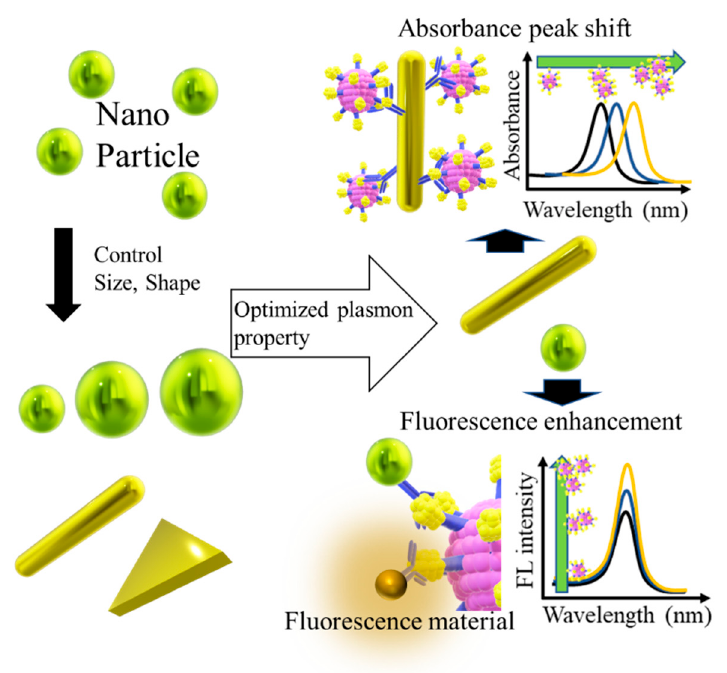
Figure 7. Basic development method of virus detection technology based on LSPR. Optimal materials with the desired plasmonic properties are obtained by controlling the shape and size of the nanoparticles. The optimal material is capable of generating a sensitive signal response in the presence of a virus.